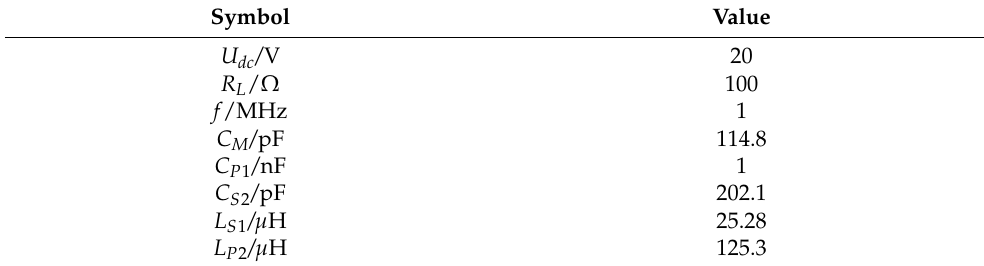
Figure 15. Experimental prototype of CPT system with LCCL compensation topology. Table 5. Experimental Parameters.